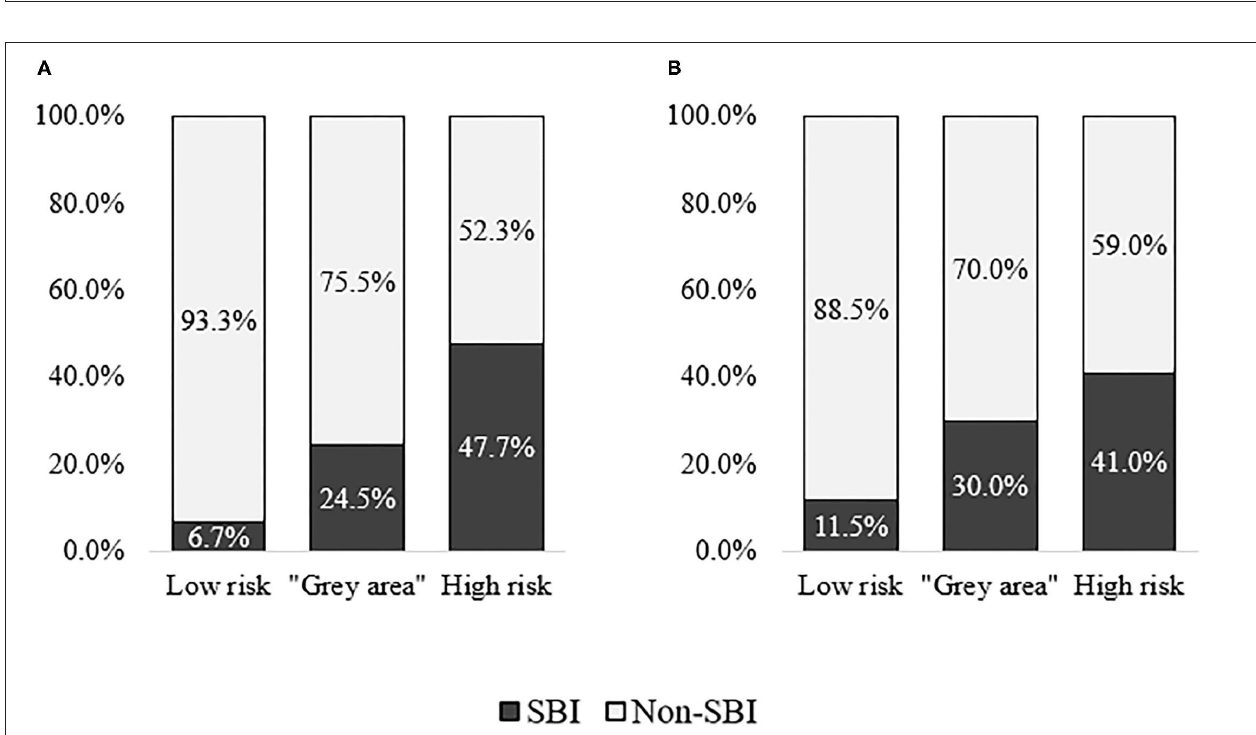
FIGURE 6 | Composition of patients with and without serious bacterial infection (SBI) within low-risk, “gray area,” and high-risk categories in derivation and validation cohorts. (A) Derivation cohort (CCUH). (B) Validation cohort (Regional hospitals).